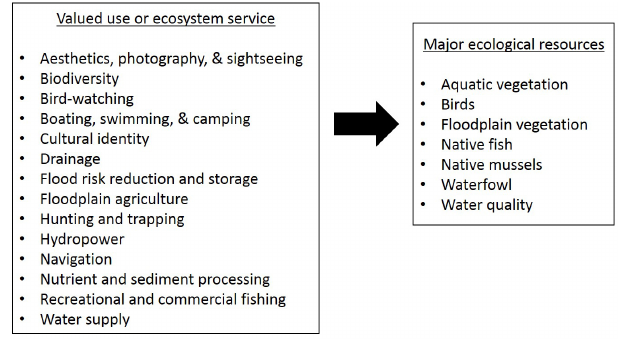
Fig. 4 . A compilation of stakeholder uses and ecosystem services provided by the Upper Mississippi River and the major ecological resources, identified through workshop discussions, program reports, and management plans, which contribute to identified uses and